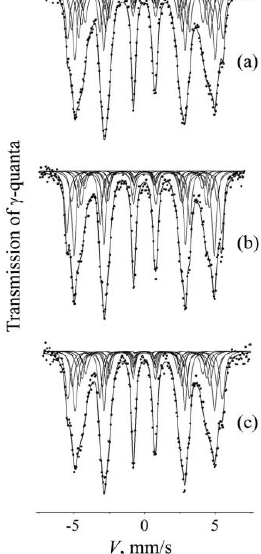
Figure 2. Spectra for the alloy Fe 86.8.2 Cr 13.2 . Treatment (state): ( a ) annealed at 1073 K (as-received); ( b ) as-received and irradiated with (fluence of) F = 2 × 10 22 m −2 at 420 K; ( c ) as-received and HPT (ε = 5.9, n = 3 rev.) at 573 K. Individual subspectra S ( N 1 , N 2 ) corresponding to atomic configurations taken into account are indicated.